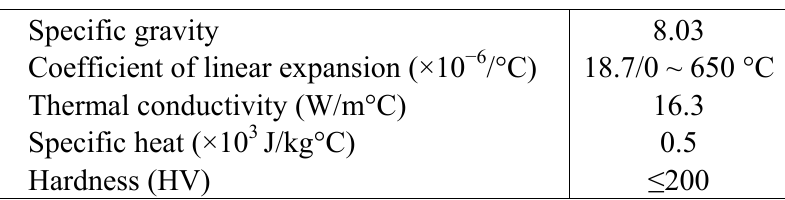
Table 1. The properties of stainless